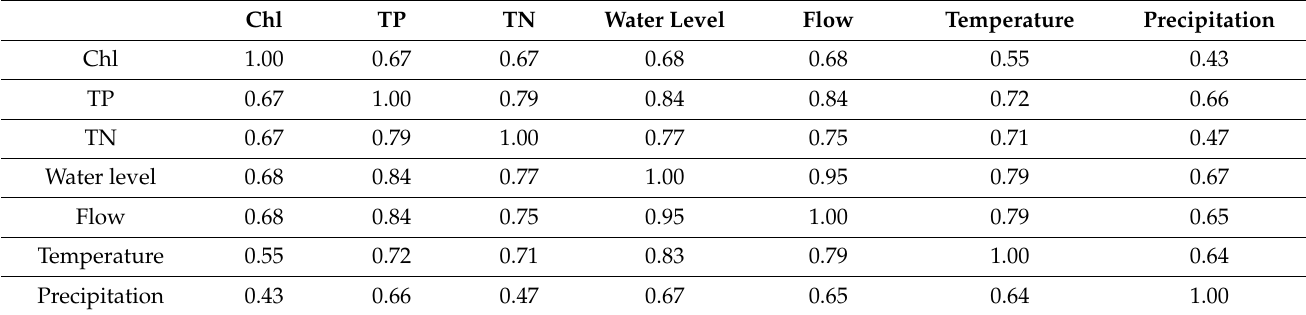
Table 3. Correlation analysis Chl-a, TN, TP, water level, flow, temperature, and precipitation. Chl TP TN Water Level